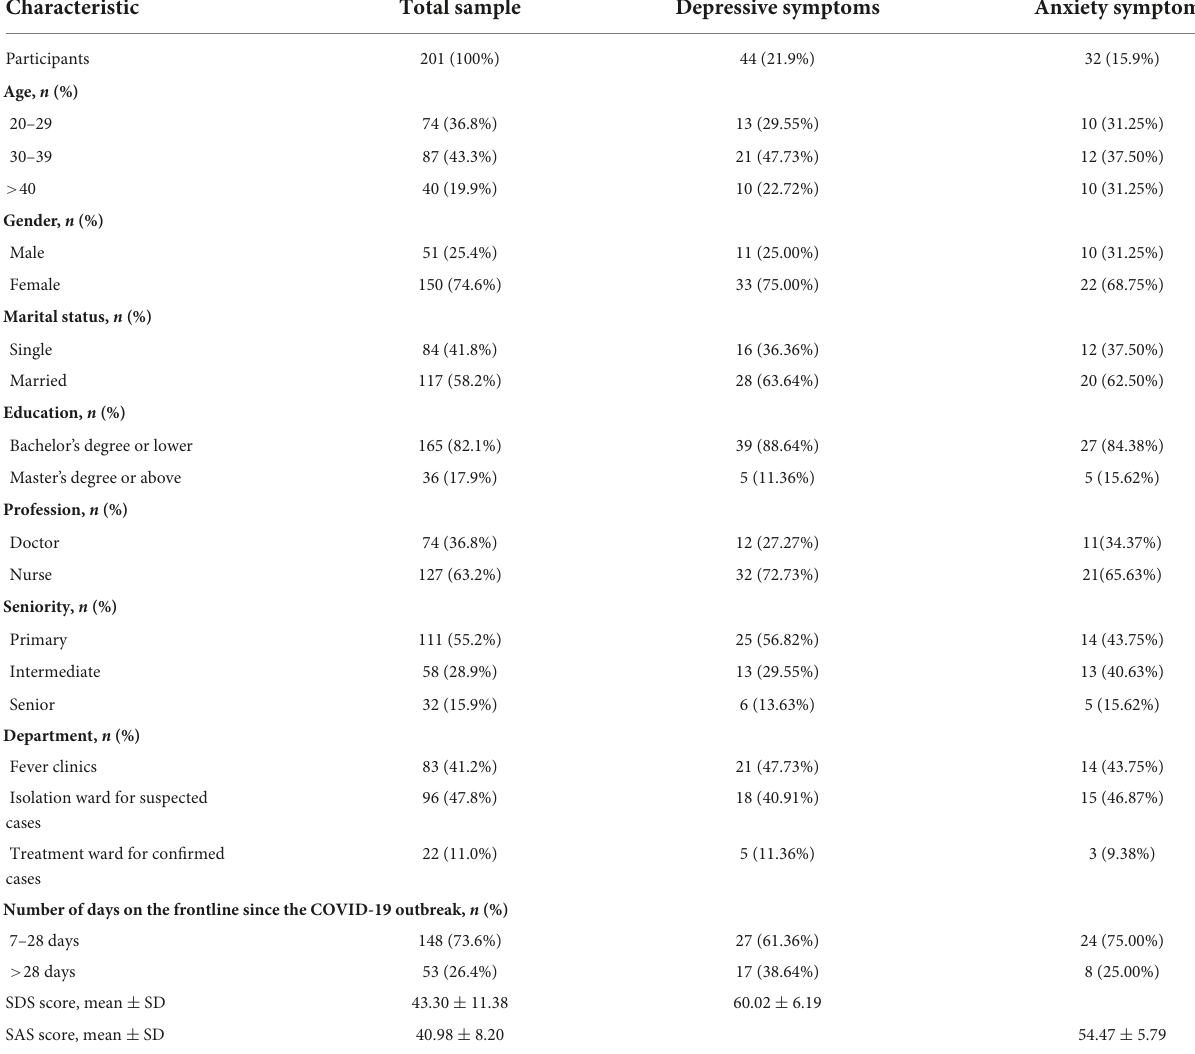
TABLE 1 The socio-demographic and clinical characteristics of the